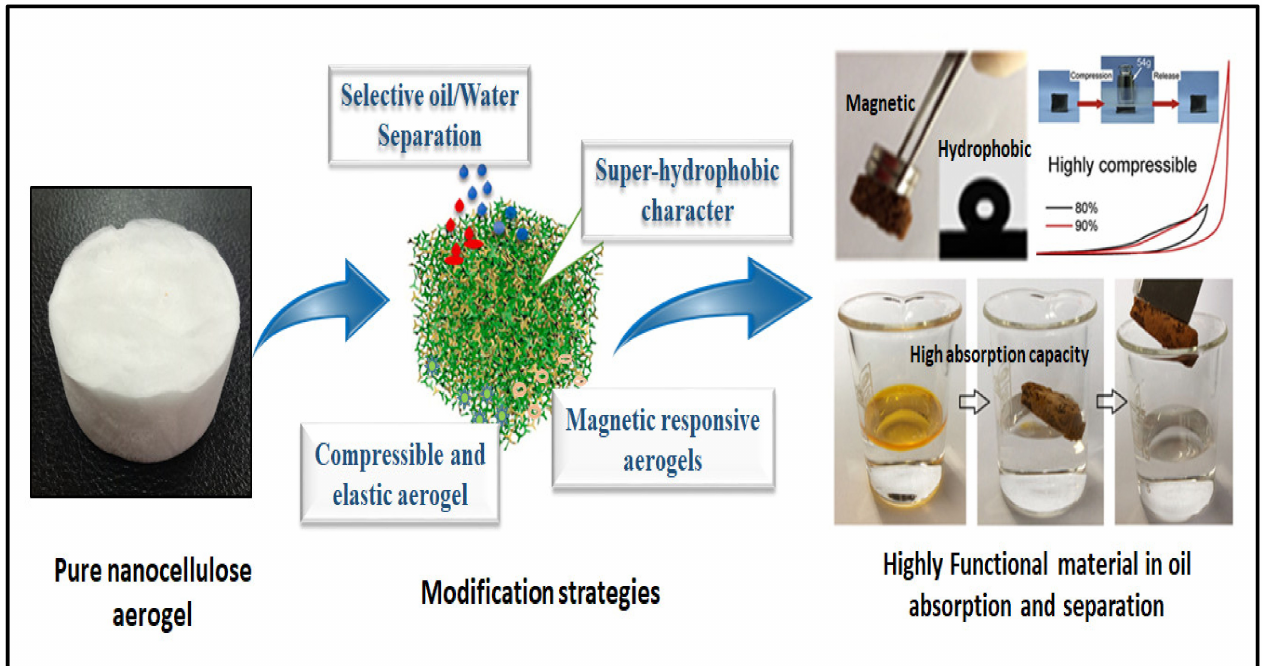
Figure 3. Illustration of commonly used modification strategies for nanocellulose aerogels to suit oil absorption and separation